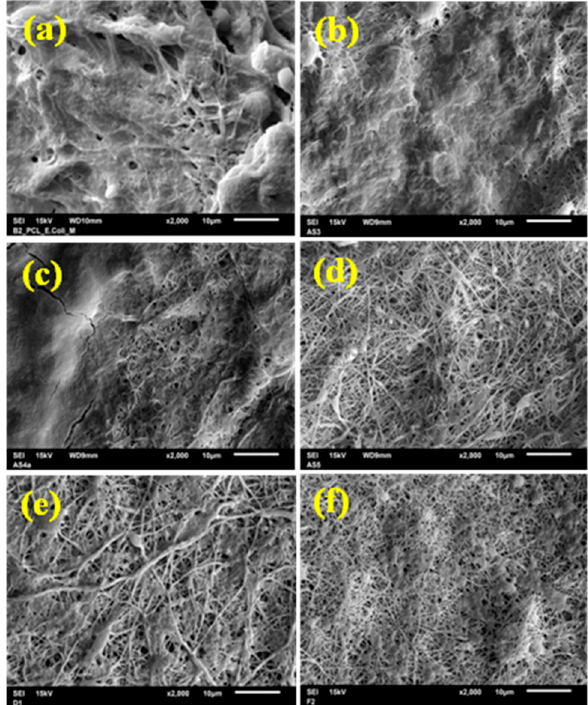
Figure 9. SEM micrograph showing the effect of the DSS concentration (wt%) on antibacterial efficacy against E. coli : pure PCL ( a ), PCL/2.5%DSS ( b ), PCL/6%DSS ( c ), PCL/12.5%DSS ( d ), PCL/25%DSS ( e ), and PCL/50%DSS ( f ) fibrous mats.